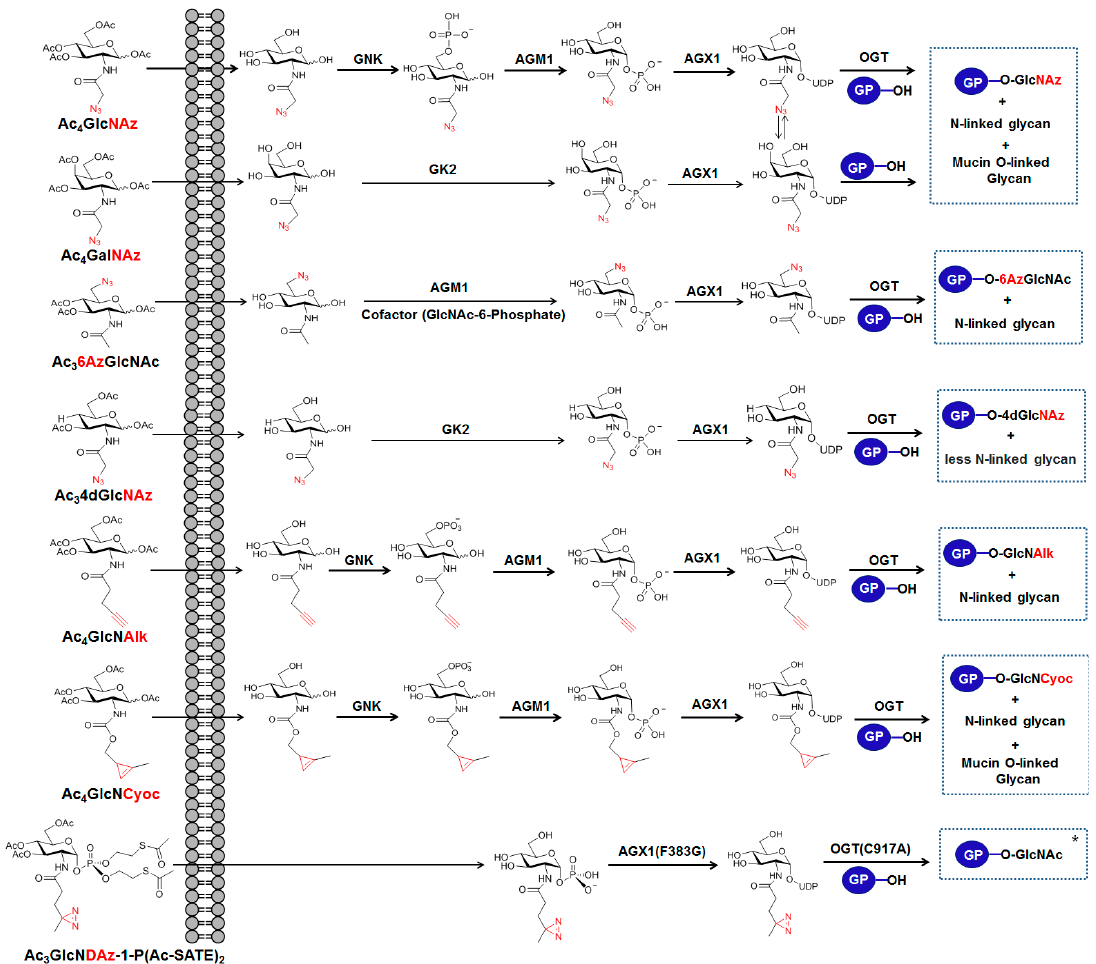
Figure 2. Metabolic chemical reporters (MCRs) of GlcNAc analogs bearing azide, alkyne or cycloproene functionalities and their possible salvage pathways.